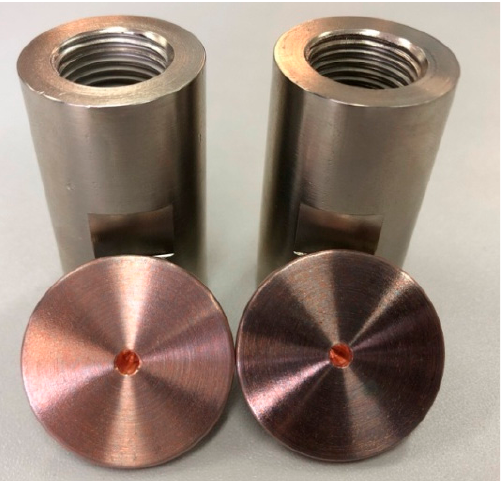
Figure 6. Test object–contact pads with attachment components for the discharge chamber.